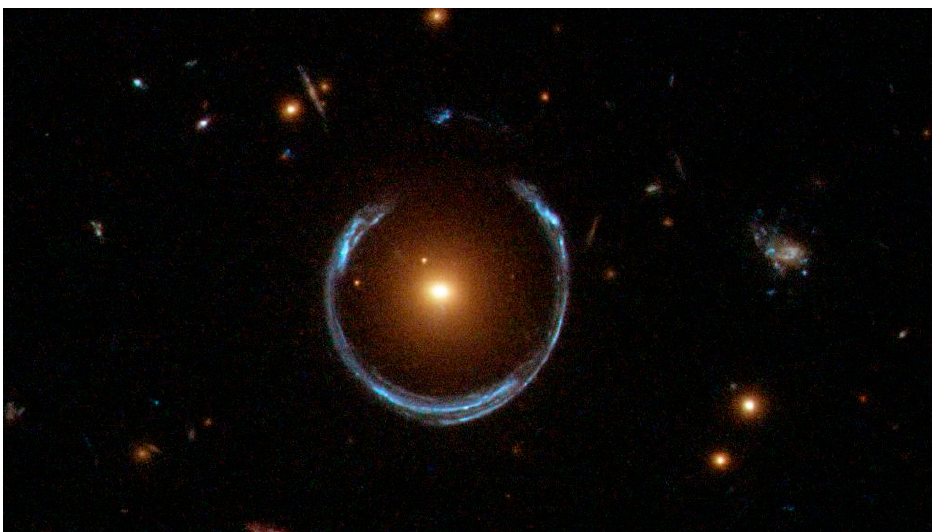
Figure 18. What is large and blue and can wrap itself around an entire galaxy? A gravitational lens mirage. Pictured above, the gravity of a luminous red galaxy (LRG) has gravitationally distorted the light from a much more distant blue galaxy. More typically, such light bending results in two discernible images of the distant galaxy, but here the lens alignment is so precise that the background galaxy is distorted into a horseshoe—a nearly complete ring. Since such a lensing effect was generally predicted in some detail by Albert Einstein over 80 years ago, rings like this are now known as Einstein Rings. Although LRG 3-757 was discovered in 2007 in data from the Sloan Digital Sky Survey (SDSS), the image shown above is a follow-up observation taken with the Hubble Space Telescope’s Wide Field Camera 3. Strong gravitational lenses like LRG 3-757 are more than oddities—their multiple properties allow astronomers to determine the mass and dark matter content of the foreground galaxy lenses. Image Credit: ESA/Hubble & NASA (citation from APOD).